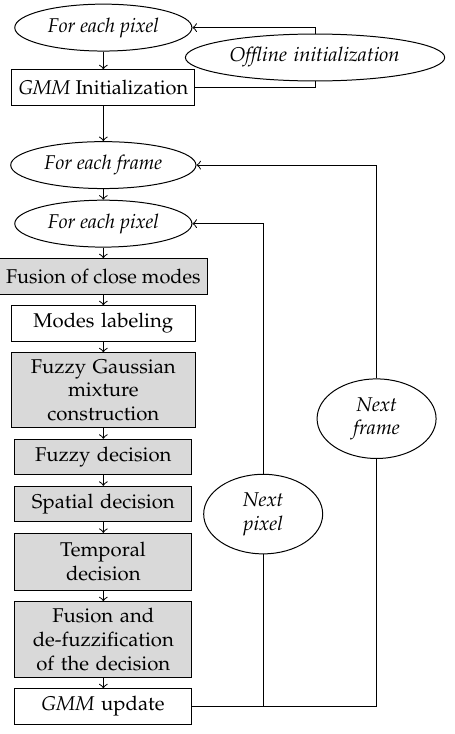
Figure 7. Algorithm of the proposed